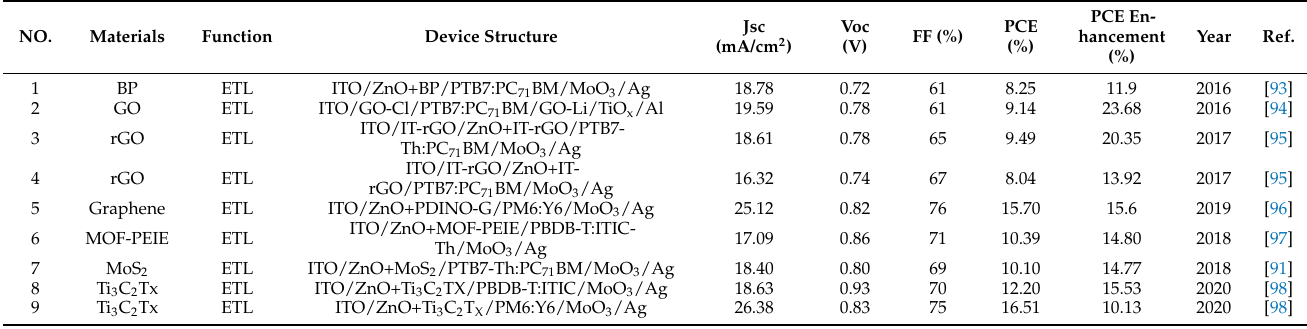
Table 4. 2D layer materials applied in the ETL of